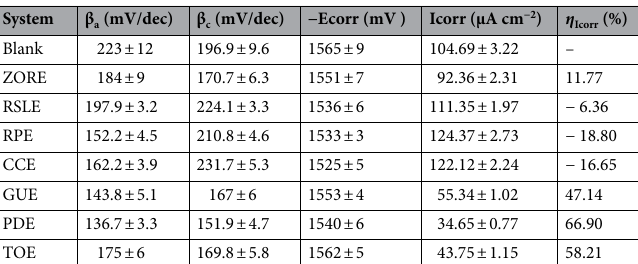
Table 1. Electrochemical parameters obtained from the polarization curves of AZ91 Mg alloy in 3.5 wt% NaCl solution without and with addition of 1 g/L seven TCM extracts at normal temperature.